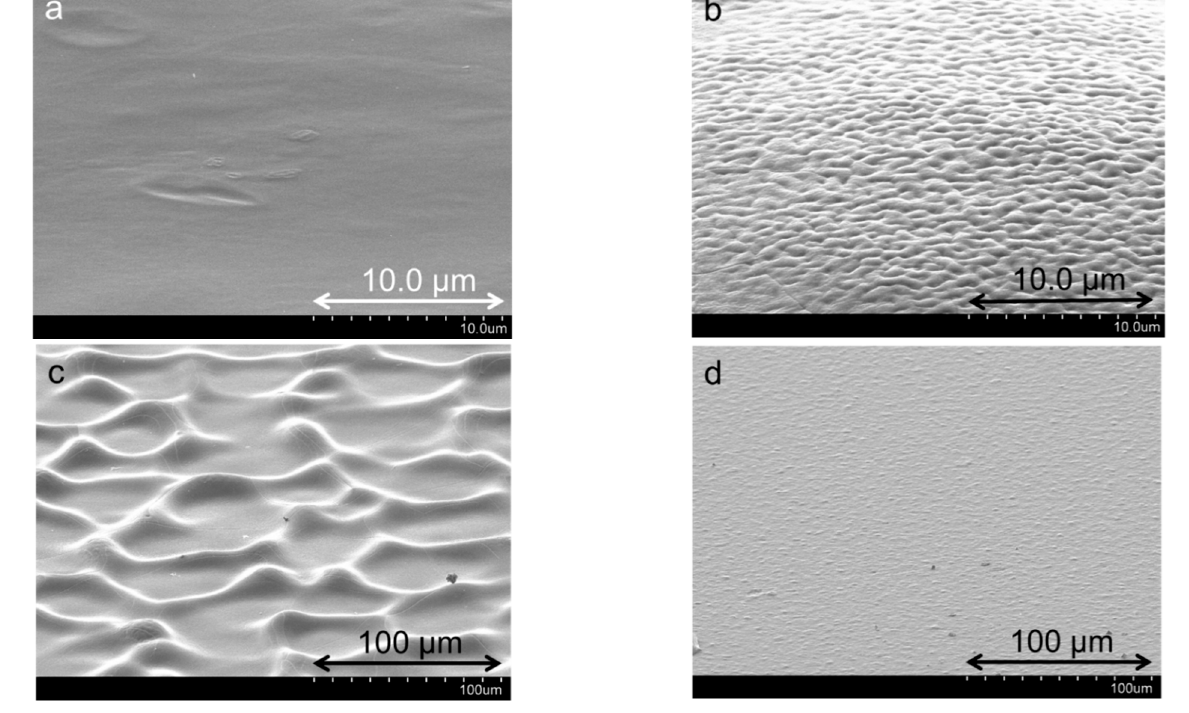
Figure 9. SEM surface images of 100 layers of ( a ) PDDA-[Laponite + PAA, 1:4], ( b ) PDDA-[Laponite + PAA, 2:3], ( c ) PDDA-[Laponite + PAA, 3:2], and ( d ) PDDA-[Laponite + PAA, 4:1] multilayers.